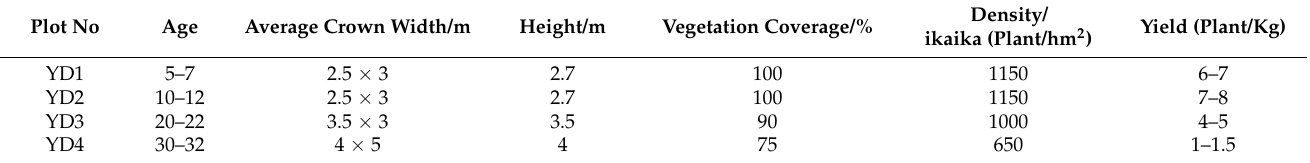
Table 1. The basic information for each sample